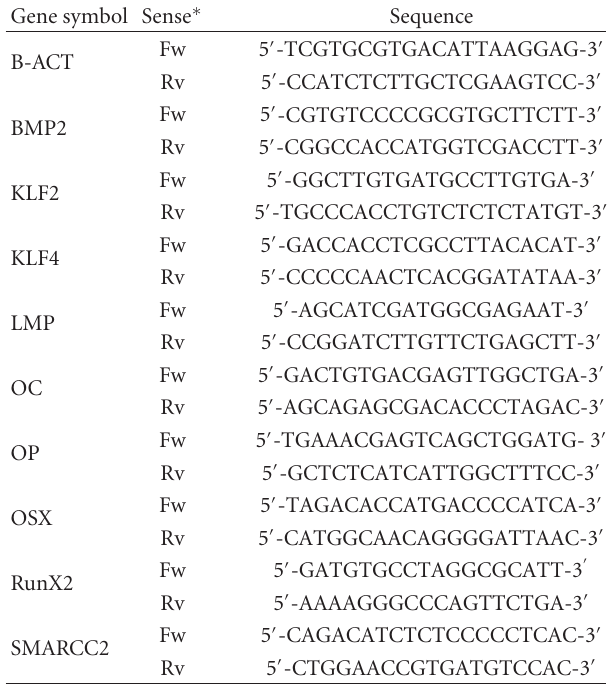
Table 1: Sequences of oligonucleotide primer used in